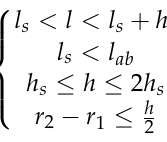
Figure 9. Schematic diagram of seed-disturbing teeth structure.